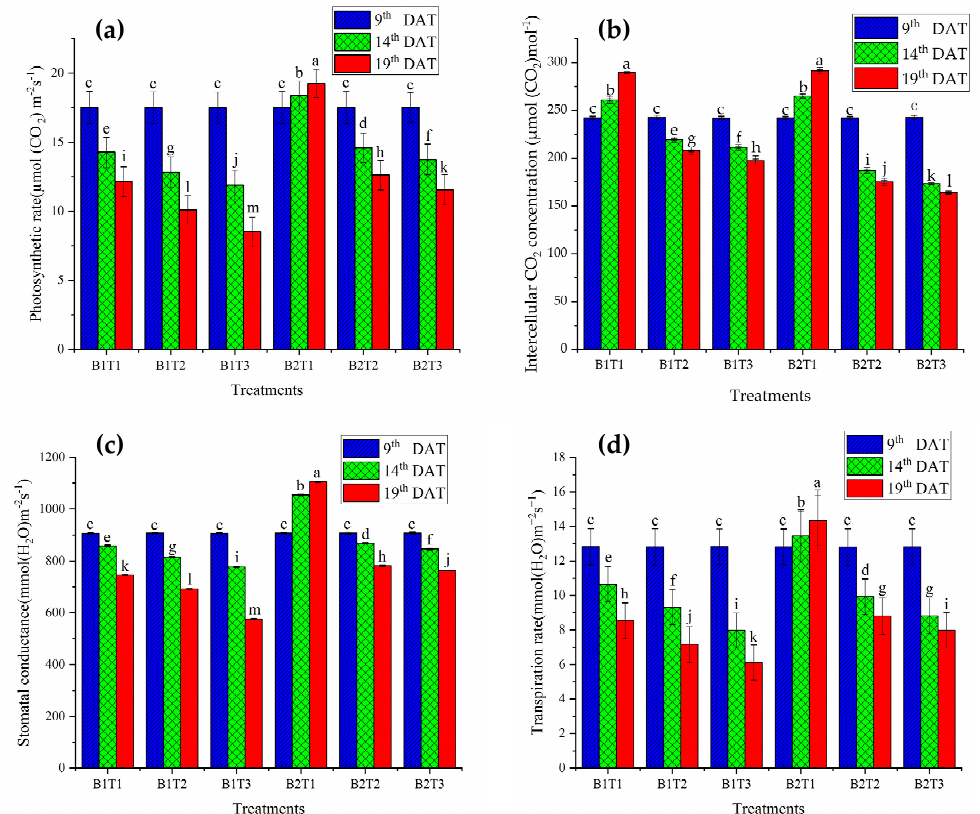
Figure 2. The effects of different water treatments and downy mildew infection on leaf photosynthetic parameters of cucumber plants. Note: Error bars indicate standard deviations, with different lowercase letters between treatments indicating significant differences at ( p < 0.05). ( a ) Photosynthetic rate; ( b ) Intercellular CO 2 concentration; ( c ) Stomatal conductance; ( d ) Transpiration rate.